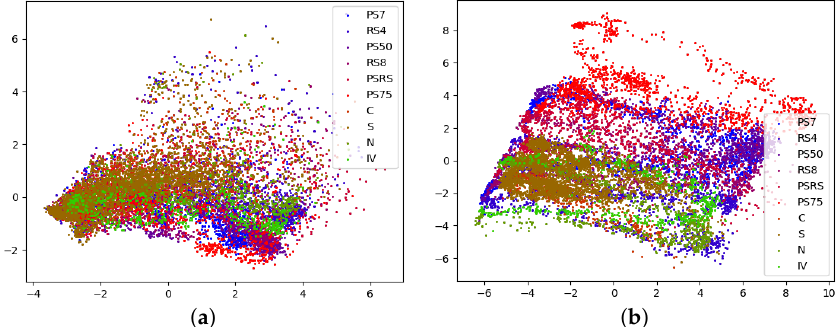
Figure 6. PCA (principal component 1 and 2) visualization of the latent space for SDGMs trained a dataset with only 100 labeled samples. ( a ) The latent space for a model trained on the simple dataset, {I, V} and ( b ) for {I, V, G, TExt, TMod, W} as